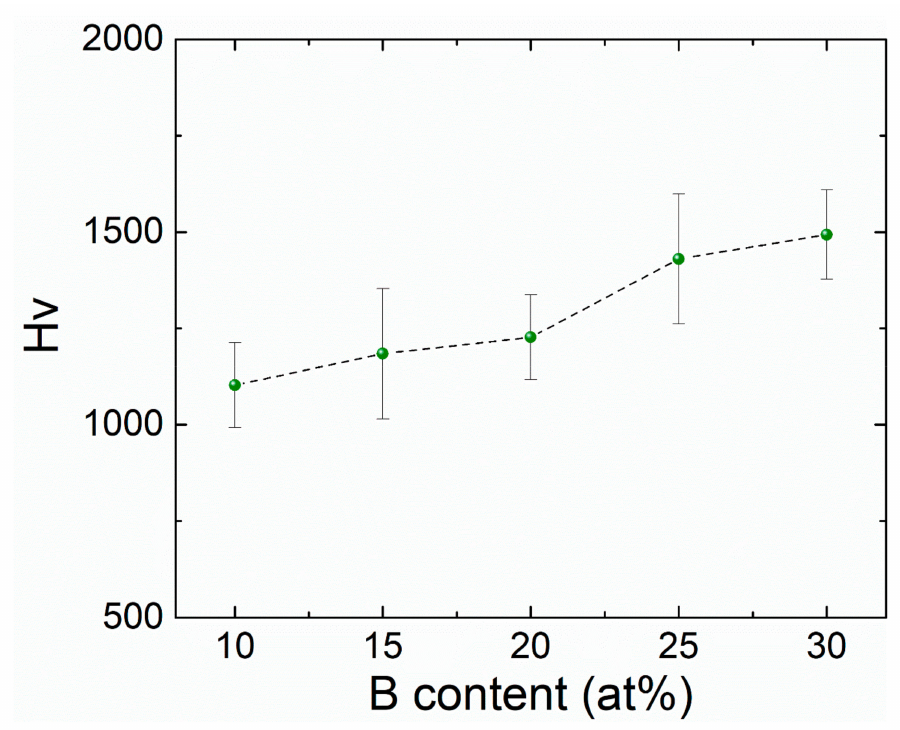
Figure 4. Variation trend in microhardness for Fe 91 − x Zr 5 Nb 4 B x (x = 10, 15, 20, 25, 30 at%) melt- spun